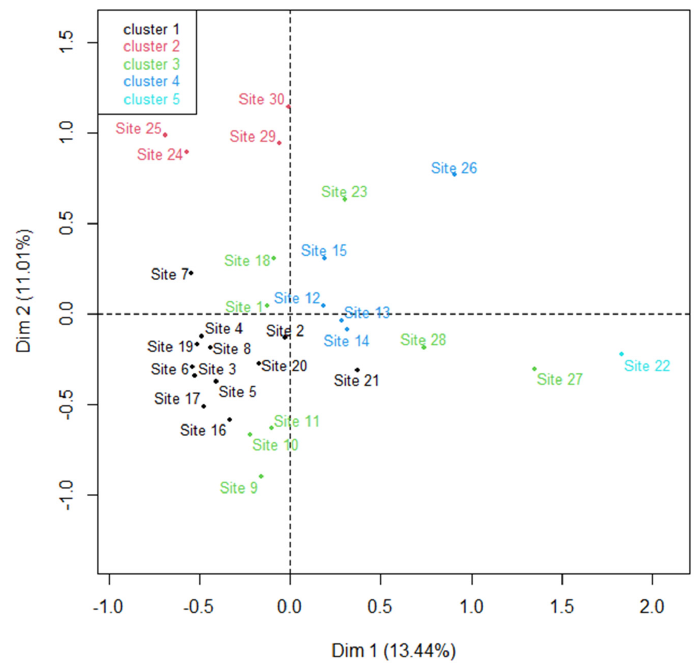
Figure 17. Representation of the study sites according to their class.